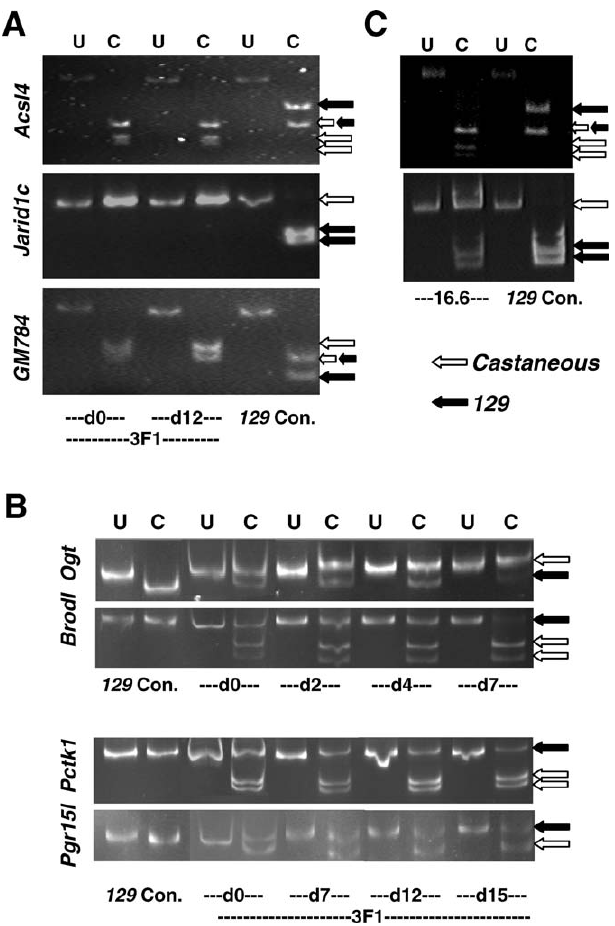
Figure 6. Allele-Specific Analysis of X-Linked Gene Expression during Differentiation of Hybrid ( 129 3 castaneous ) Female ES Cells (A) Electrophoretic separation of cDNA restriction fragments from the three cluster 4 genes Acsl4 , Jarid1c , and GM784 reveals allele-specific expression. PCR fragments that are specific for each gene were prepared from cDNAs from undifferentiated (day 0) or differentiated (day 12) 3F1 hybrid ES cells. Fragments were uncut (U) or cut (C) with restriction enzymes, so as to reveal SNPs that distinguish m.m.domesticus ( 129 , black arrows) and m.m.castaneous (white arrows) alleles. Small double arrows show where bands of the same size are generated from 129 and castaneous . For all three genes, the expected 129 product is missing from both undifferentiated (day 0) and differentiated (day 12) cells, showing that expression is exclusively from the castaneous allele. cDNA from the male CCE/R ES cell line provided the 129 control. Details of primers, restriction enzymes, and expected fragment sizes are given in Table S5. (B) Electrophoretic separation of cDNA restriction fragments from four X- linked genes Ogt , Brodl , Pctk1 , and Pgr15l to reveal allele-specific expression in 3F1 hybrid female ES cells at different days of differ- entiation (days 0–15 as indicated); labelling as for (A). (C) In undifferentiated 16.6 hybrid female ES cells, cluster 4 gene Acsl4 (upper gel) shows monoallelic expression ( castaneous allele only) while Jarid1c (lower gel) is expressed from both alleles; labelling as for